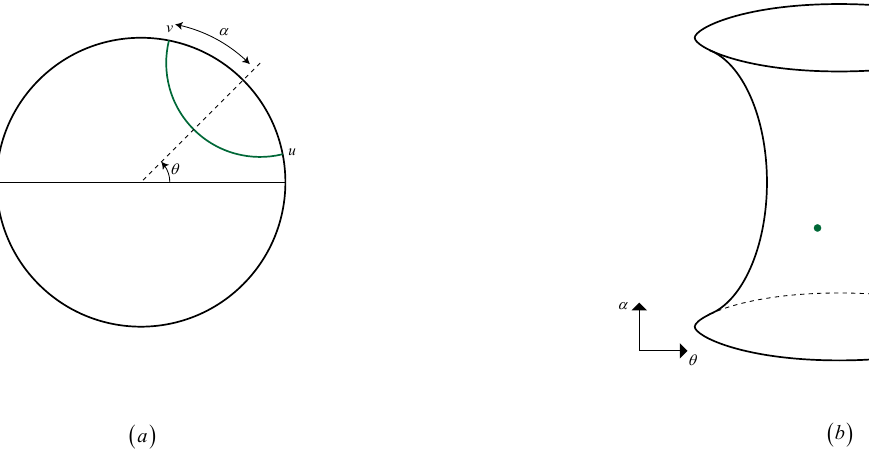
Figure 9 . Geodesics (green lines) in the hyperbolic plane (left figure) are mapped to points on kinematic space (right